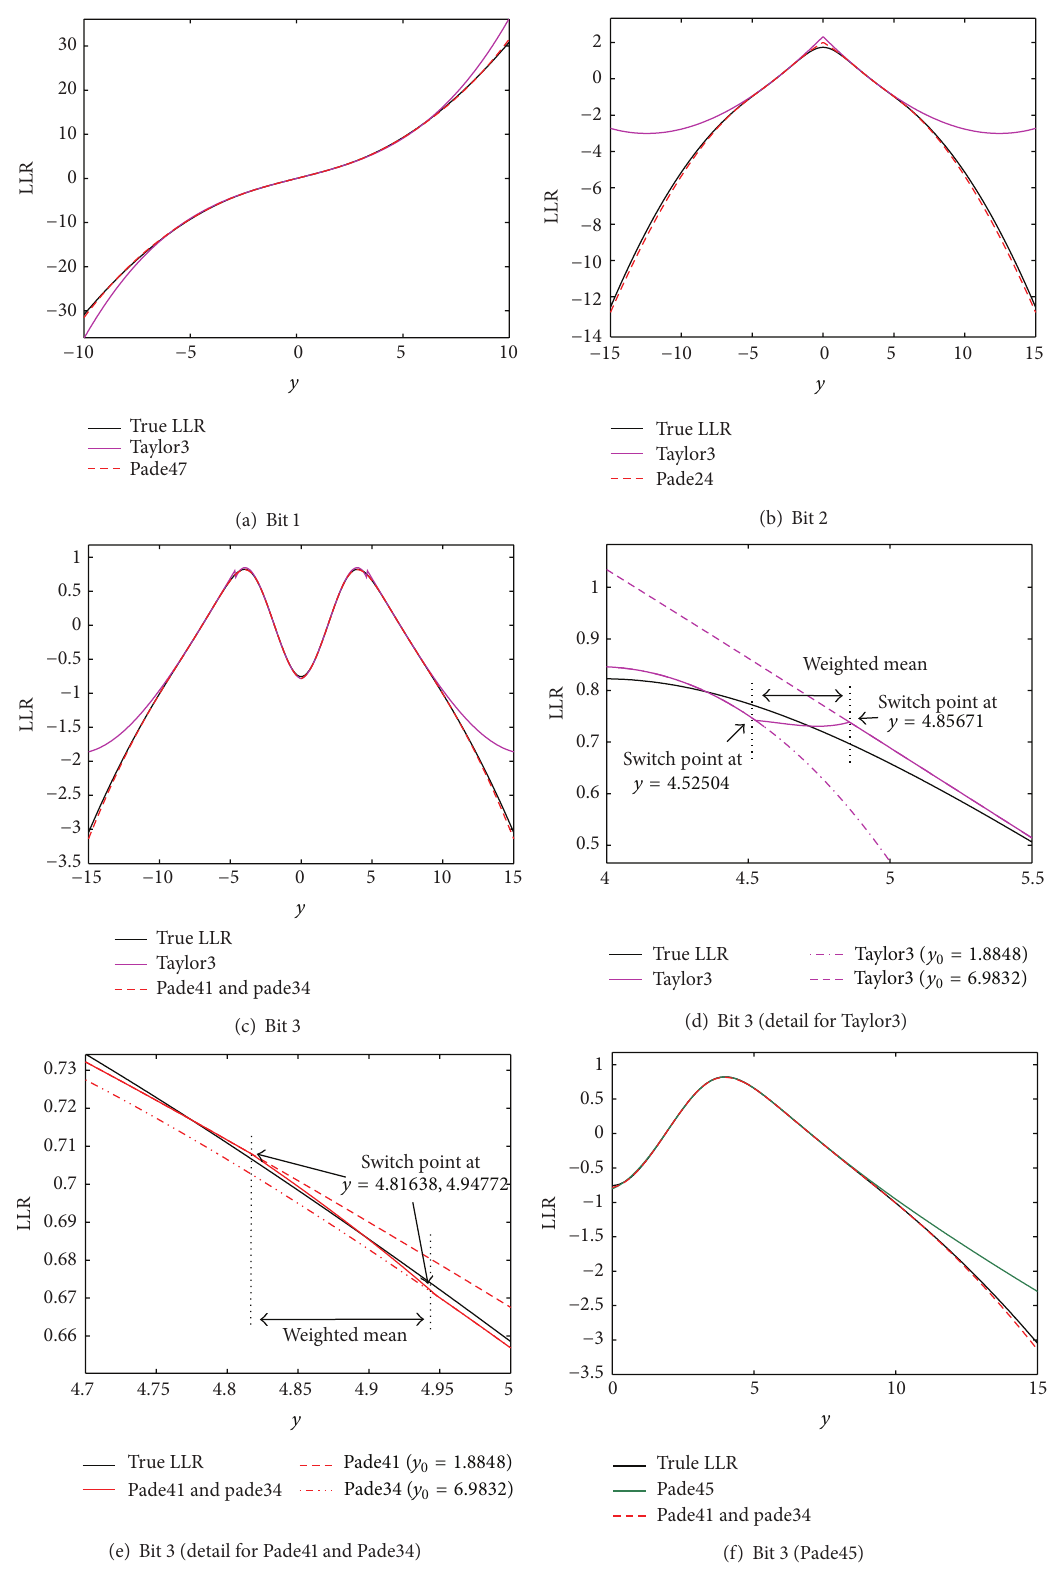
Figure 4: Comparison of bitwise True LLR and approximated LLRs for the 8-PAM with Gray labeling (SNR = 7.91 ( 𝜎 = 1.699